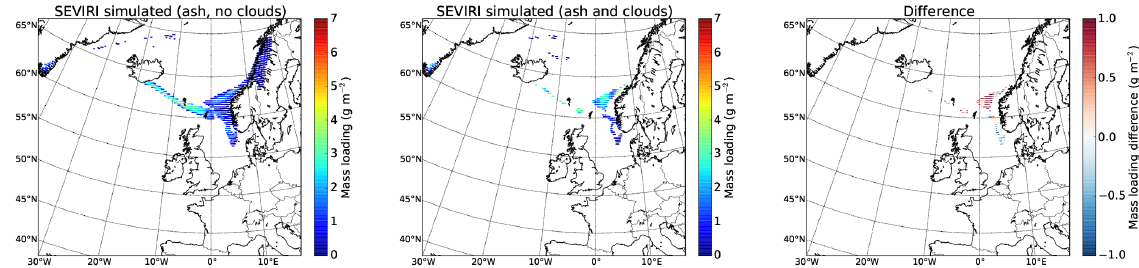
Figure 5. Ash retrieval: the ash-mass loading retrieved from cloudless simulated SEVIRI images (left), and including clouds (middle). The difference (cloudy–cloudless) between the ash-mass loading retrieved for pixels identified as ash in both the cloudy and cloudless simulations (right). All data representative for 12:00UTC, 15 April, 2010.